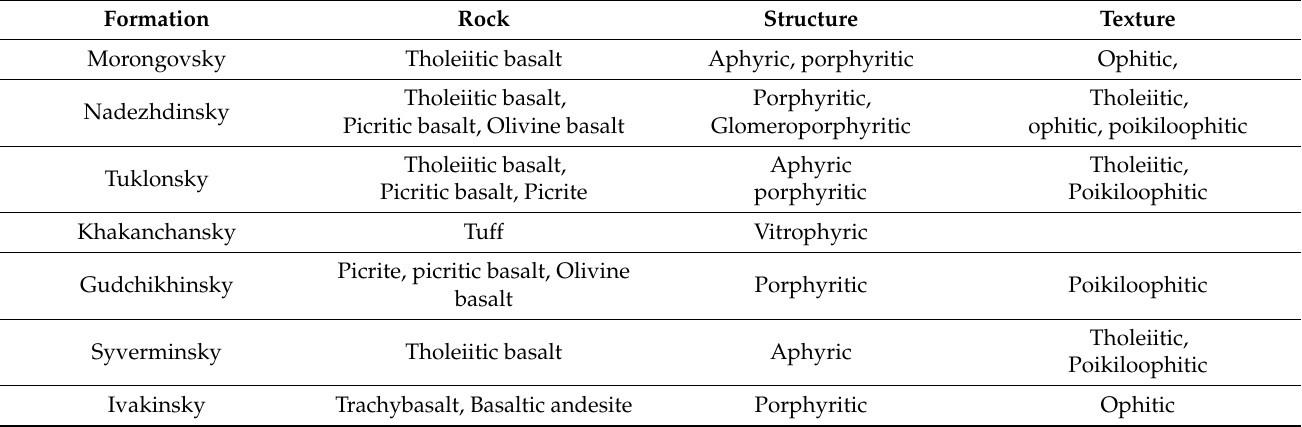
Table 1. Textural–structural characteristics of the effusive rocks, NW Siberian